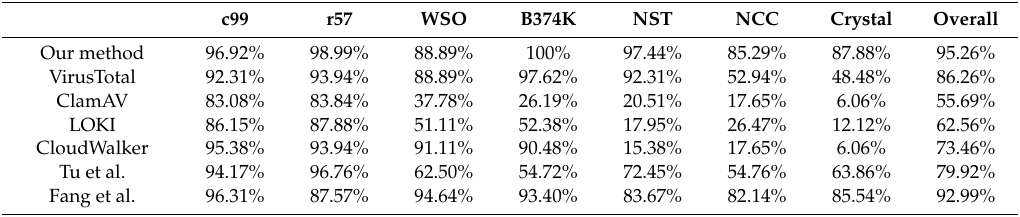
Table 5. Comparison average in TPR results of various advanced web shell detectors and di ff erent web shell families. All the results are based on the average of 100 independently repeated